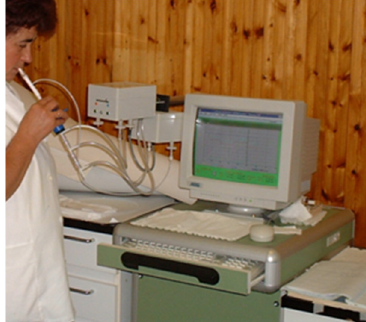
Figure 1. One of the original chemiluminescence analyzers ( Logan model LR2500, Logan Research; Rochester, Kent, UK) for online measurement of exhaled NO in the early nineties . The analyzer is sensitive to NO from 1 ppb (by volume) to 5000 ppb with a resolution of 0.3 ppb. It also measures CO 2 (resolution 0.1% CO 2 ; response time, 200 ms) in real time. The subject exhales slowly (5–6 L/min) from total lung capacity for 15–20 s against resistance to exclude nasal contamination. During expiration the pressure is kept constant (3 ± 0.4 mm Hg) by using a visual display of expiratory flow measured by pressure and volume sensors in the analyzer.